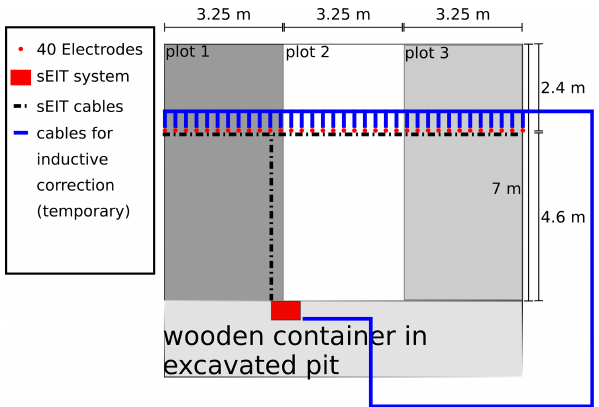
Figure 1. Overview of the field site, including location of measure- ment system (in a wooden container installed in an excavated pit next to the measurement field), the cable layout of the sEIT sys- tem, electrode positions, and calibration cable layout temporarily used for measurement of inductive calibration data (discussed in Sect. 4.3). Plots 1–3 denote different agricultural treatments of the field, not further discussed